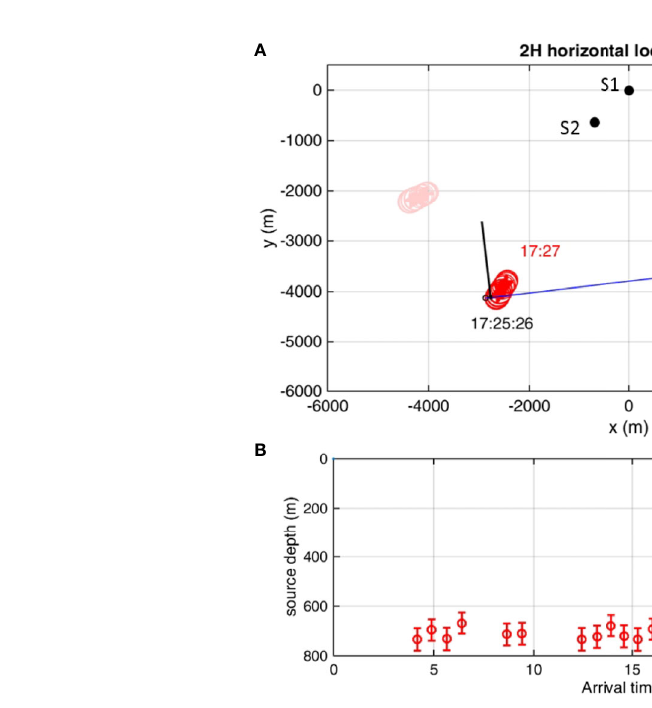
FIGURE 12 | Localization results (in red) on 21 July 2021 at 17:27 (A) in the horizontal and (B) in the vertical based on receptions at SWAN1 and SWAN2 hydrophones. The symmetric solutions in the horizontal are also shown (light red) in (A) . The blue line and the open circle in (A) show the vessel course and position, respectively, at 17:25:26; the black line shows the broadside direction of the towed array of hydrophones.